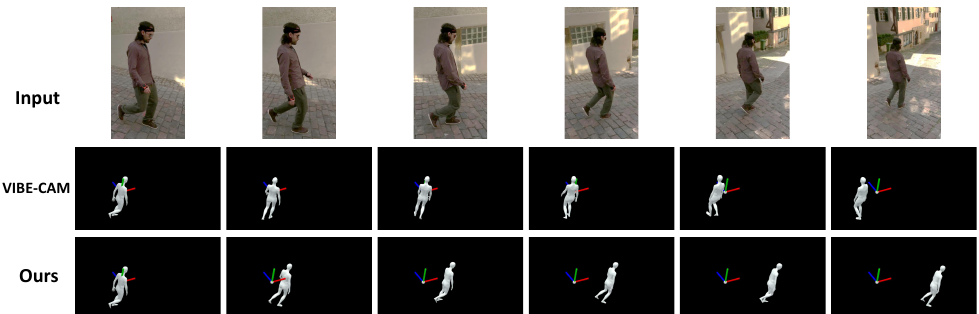
Figure 9. Qualitative results on the 3DPW dataset. The downtown_walkDownhill_00 sequence is used as input to VIBE-CAM and our